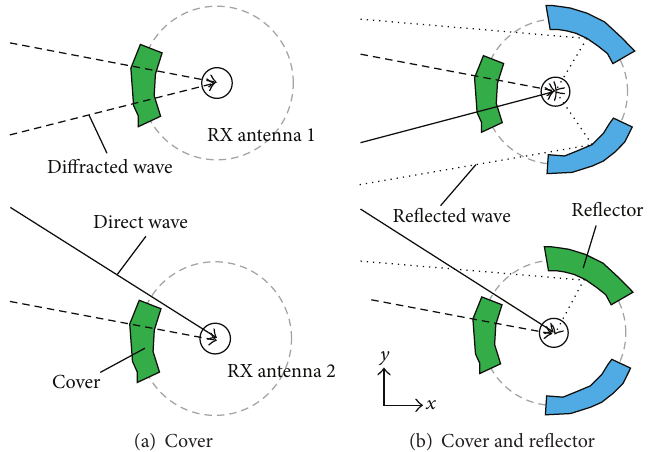
Figure 14: Incident paths of radio waves for cover and reflector.